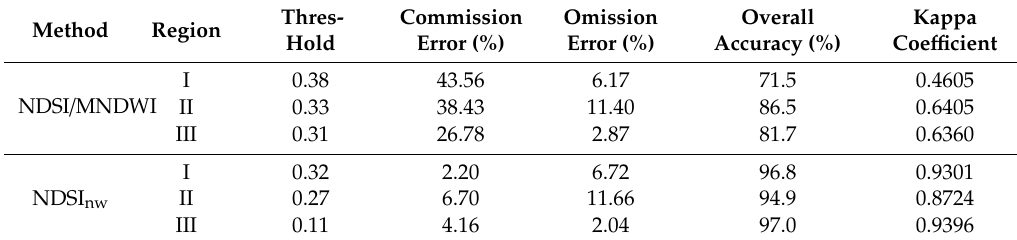
Table 6. The extraction accuracy of SCG from lake water